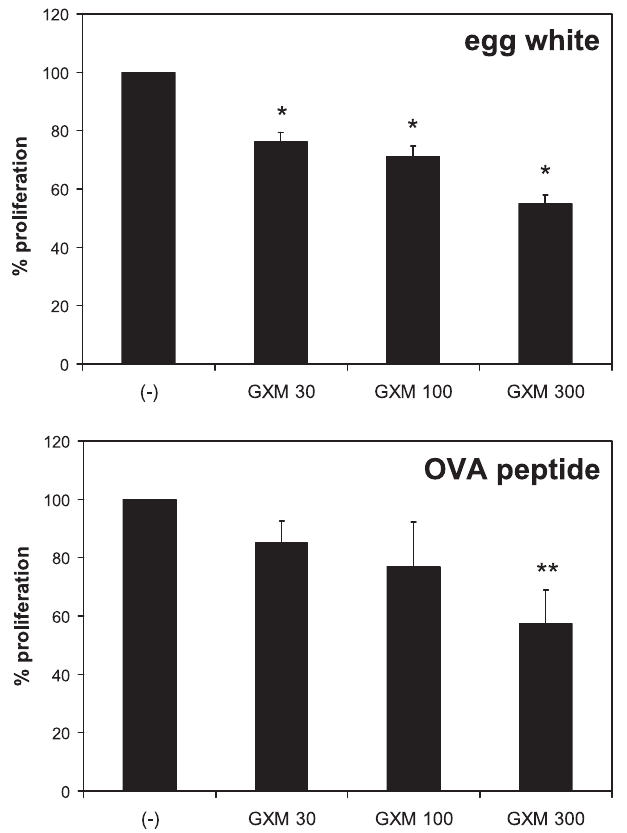
Figure 3. GXM Inhibits the Proliferation of OVA-Specific T Cells BMDCs were pretreated with GXM (30, 100, or 300 l g/ml) before the addition of egg white or OVA 323–339 peptide. Purified CD4 þ T cells from OT-II mice were then added and proliferation was measured by [ 3 H]thymidine incorporation. The data are expressed as the percent proliferation compared with antigen alone ( (cid:1) ) (set at 100%) 6 SEM of three independent experiments done in triplicate. Mean CPM for egg white and OVA 323–339 peptide were 116,830 and 220,560, respectively. * p , 0.01; ** p (cid:2)